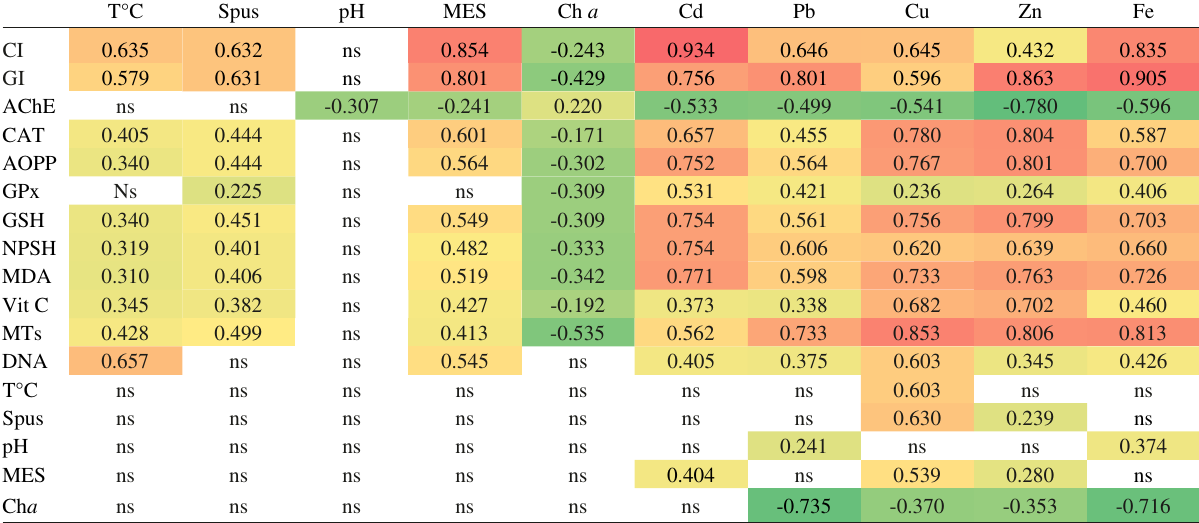
S4. – Correlation matrix of non-parametric Spearman’s rank correlation coefficients between R. decussatus biomarkers, trace element digestive gland tissue levels (Cd, Pb, Cu, Zn, and Fe) and environmental parameters measured in this study. AChE, acetylcholinesterase; CAT, catalase; AOPP, advanced oxidation proteins products; GPx, glutathione peroxidase; GSH, gluthatione; NPSH, non-protein SH; MDA, malondialdehyde; Vit C, vitamin C; MTs, metallothioniens; T, temperature; S, salinity; pH, hydrogen potential; SPM, suspended matter;